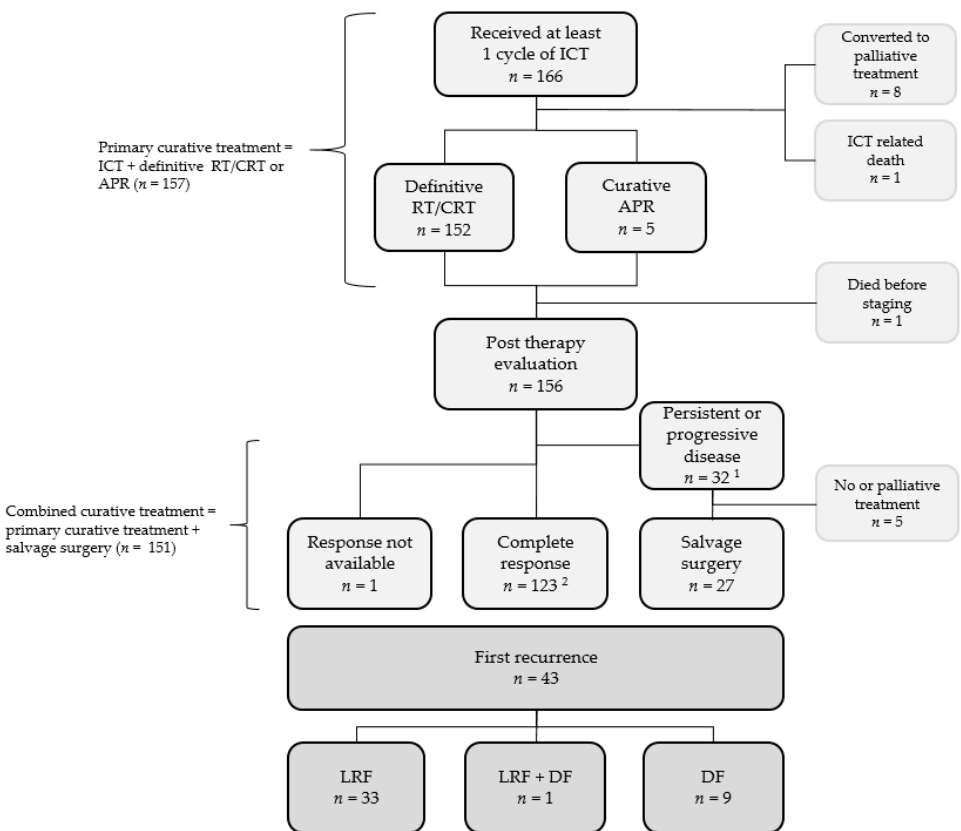
Figure 1. Flowchart of completed therapy, treatment response, and recurrence. 1 Persistent disease ( n = 28) and progressive disease ( n = 4). 2 Including three patients with no tumor cells in the specimen after salvage surgery. Abbreviations: RT, radiotherapy; CRT, chemoradiotherapy; APR, abdominal perineal resection; LRF, locoregional failure; DF, distant failure.